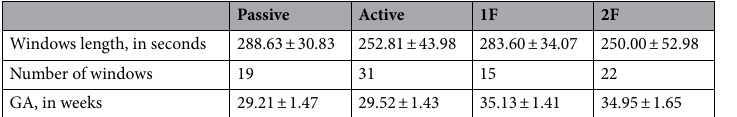
Table 3. Characteristics of the 87 data segments that were chosen for further evaluation [mean ± standard deviation].